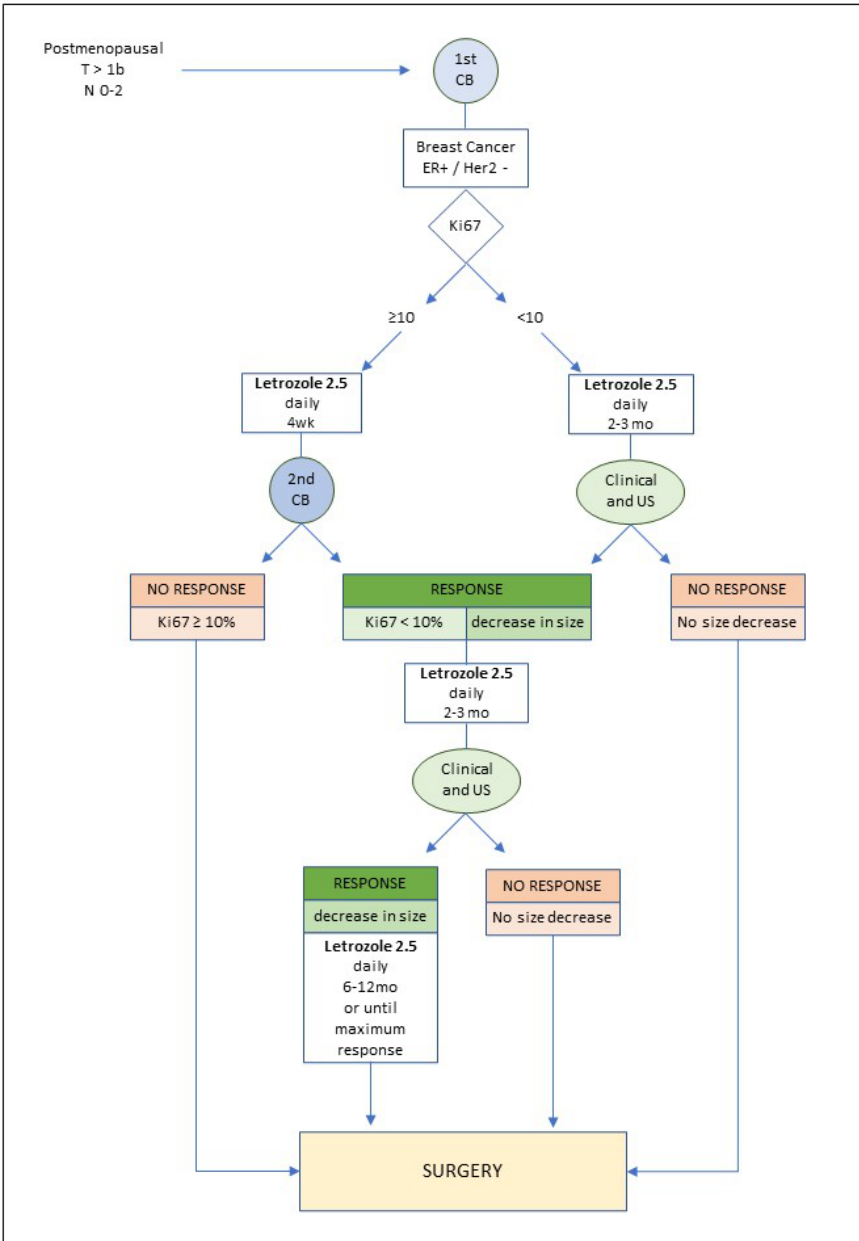
Figure 1. Study protocol. CB: core biopsy; wk: week; mo: month; US: ultrasound. Data were collected from patient charts, including the following: age; histological type (ductal, lobular, other); histologic grade (G1, G2, or G3); ER; progesterone receptor (PR); Ki67 expression (%) (pretreatment, intermedial, and in the surgical sample); clinical and pathological size (mm); clinical node status (positive or negative); clinical stage (TNM) [24]; duration of treatment (months); surgical approach (lumpectomy or mastectomy); upfront axillary surgery (sentinel lymph node biopsy (SLNB), targeted axillary dissection (TAD), axillary lymph node dissection (ALND), or none). Immunohistochemistry for ER (clone EP1, prediluted, Dako, Glostrup, Denmark) and PR (clone PgR 1294, prediluted, Dako) was performed according to international guidelines. Ki67 proliferation rate (clone MIB1, prediluted, Dako) was defined as the mean expression in the whole tumor area [25]. Negative HER2 status was confirmed by either immunohistochemistry (HercepTest, Dako), or by in situ fluorescent